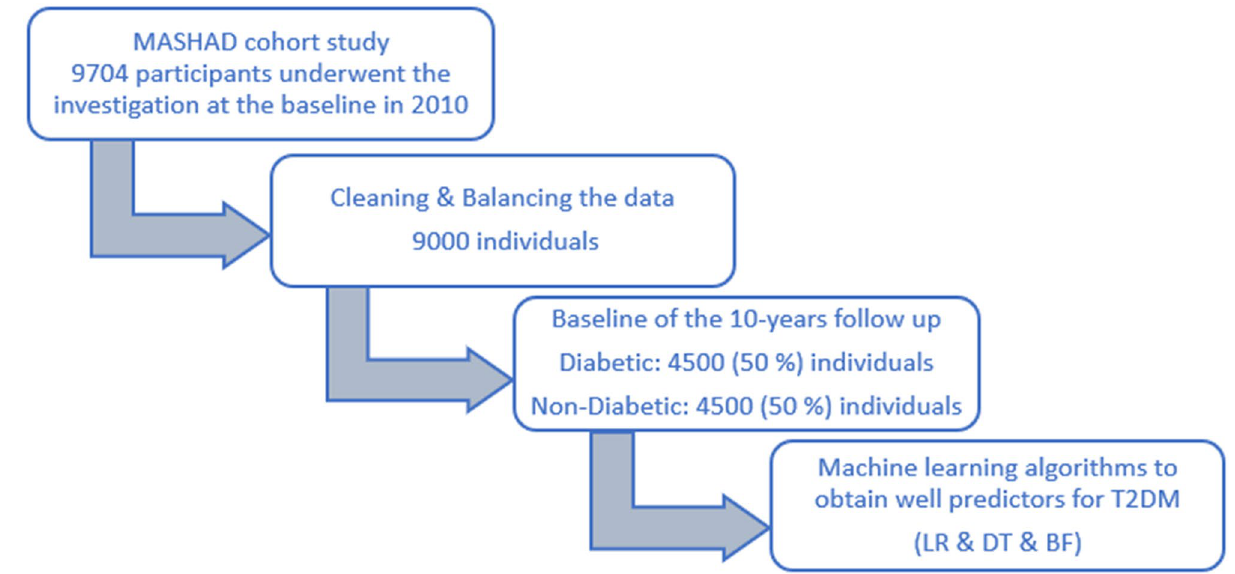
Figure 1. Flow chart of this